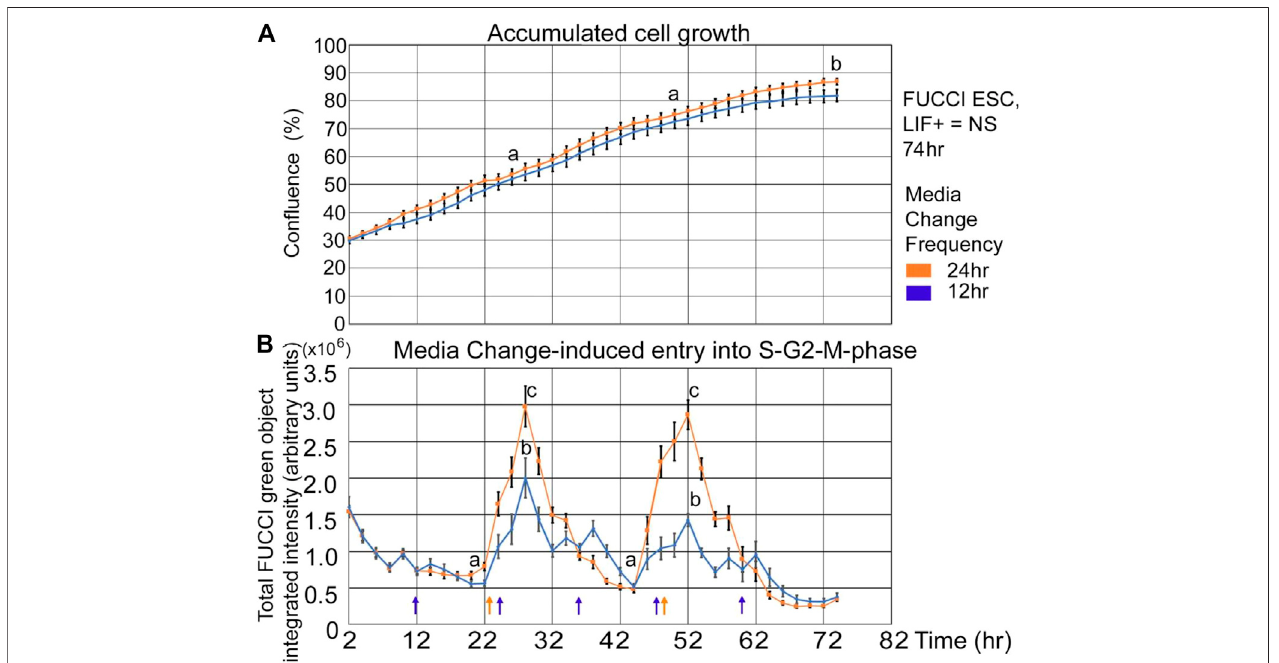
FIGURE1| FUCCIESCsaccumulateinanS-shapedcurve,butmedium changerevealsthatcellsaccumulateinthegreen-negativestate(G1)approachinga24-h interval feeding and then rapidly re-entering the green S-G2-M-phase after medium change. FUCCI ESCs were passed into 96-well plates and 18 h later had the fi rst mediumchangeofNS/LIF+mediaatTzero,placedinaliveimager,werefedat24and48 h,or12,24,36,48,and60 h(shownbyarrowsinPanel1B),andthenassayed every2 hoursforcon fl uence (A) orFUCCItotalobjectgreenintensity (B) inanIncuCyteZoomliveimager.Thetimesformediumchangemayvaryby2 hours.Error barsares.e.m.from fi veindependentbiologicalexperimentsfor12 handsixindependentexperimentsfor24hfeedingfrequency,respectively.InPanel1A,(a)showsno signi fi cant difference between 12- and 24-h feeding at 24 and 48 h, but (b) shows signi fi cant difference at 74 h ( p < 0.05). In Panel 1B, the nadirs (a) are signi fi cantly different than the peaks (b, c) for both feeding schedules ( p < 0.0001). N (cid:1) 26; 12-h feed: fi ve biological experiments, N (cid:1) 15.